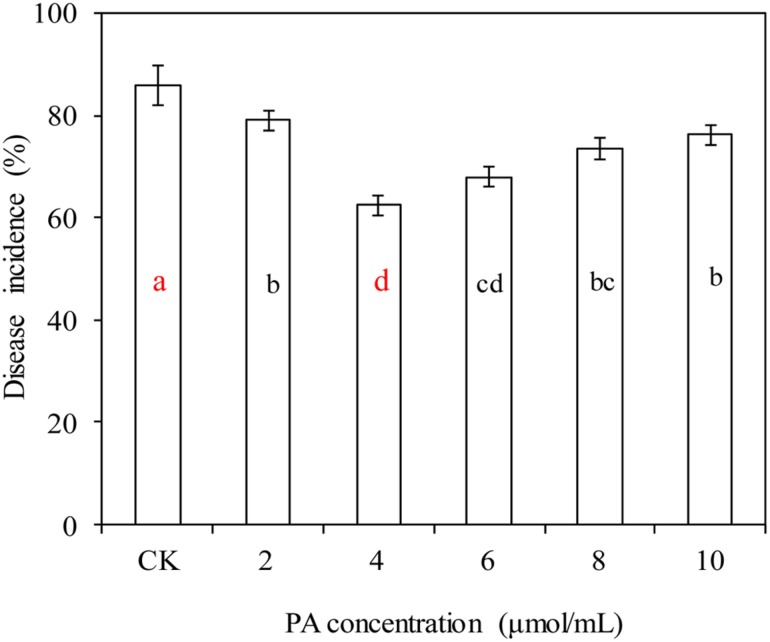
Effects of phytic acid (PA) at various concentrations on blue mold decay of apples. Fruit treatments are as follows: CK = sterile distilled water, (2, 4, 6, 8, 10) = PA at different concentrations (2, 4, 6, 8, and 10 μmol/mL). Each value is the mean of two experiments. Bars represent standard deviations. Different letters indicate significant differences (P < 0.05) according to the Duncan’s multiple range tests.